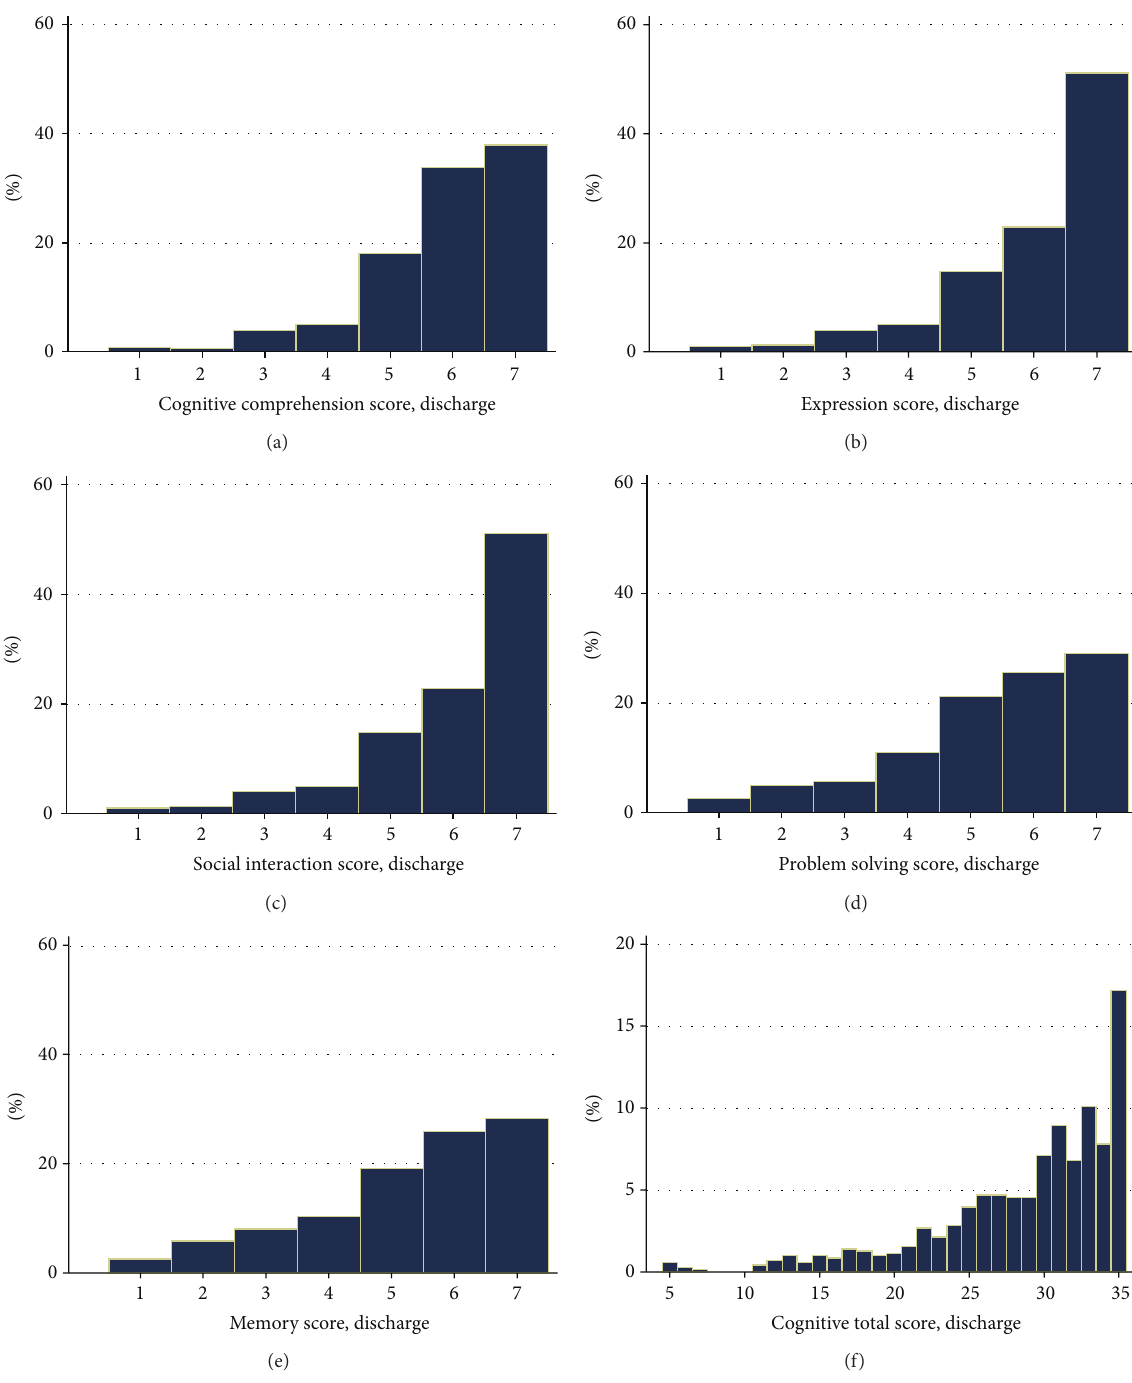
Figure 2: Frequency of Functional Independence Measure Cognitive items scores ((a) to (e)) and total Cognitive score (f) at discharge